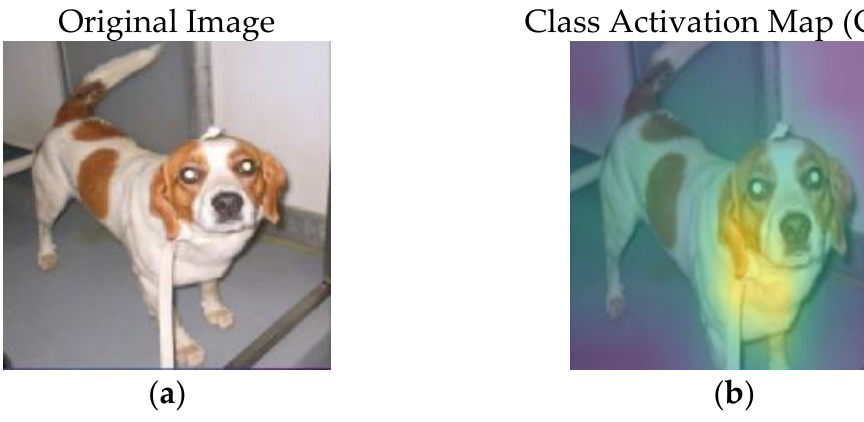
Figure 2. ( a ) Input image; ( b ) output of class activation map (CAM).